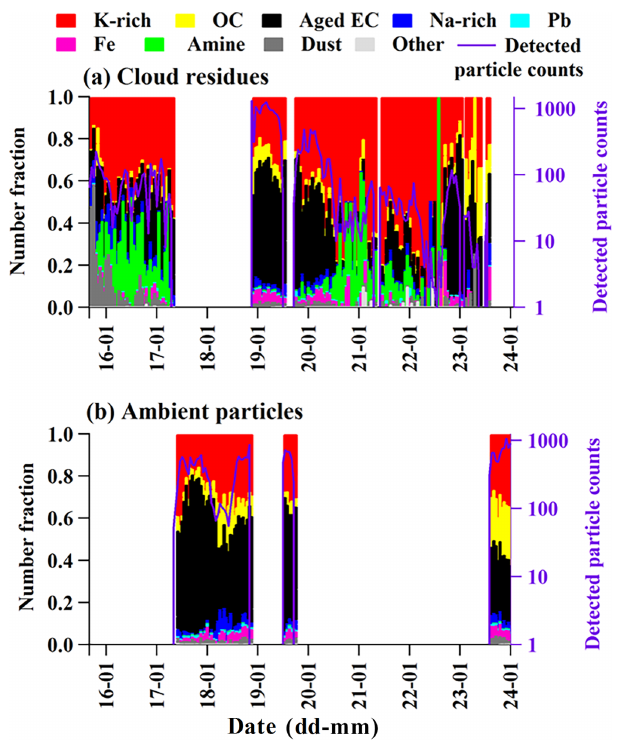
Figure 6. The hourly average variations in the cloud residual and ambient particles during the whole sampling